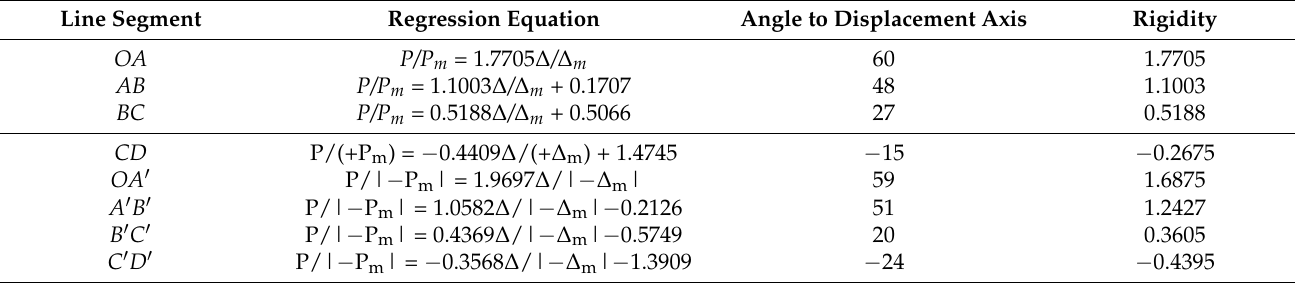
Table 9. Linear equation and stiffness of each stage in skeleton curve model of exterior